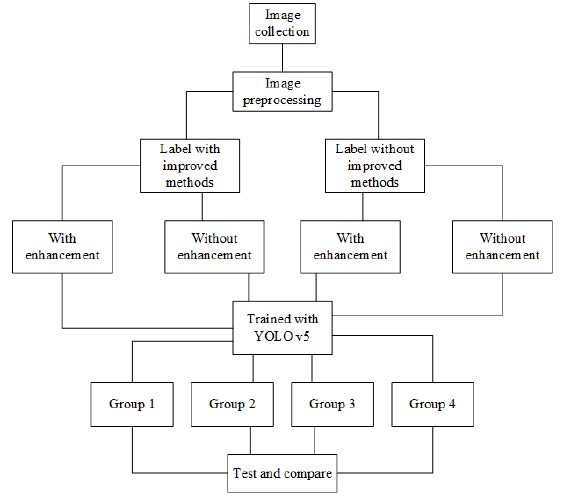
Figure 9. Overall flow chart.